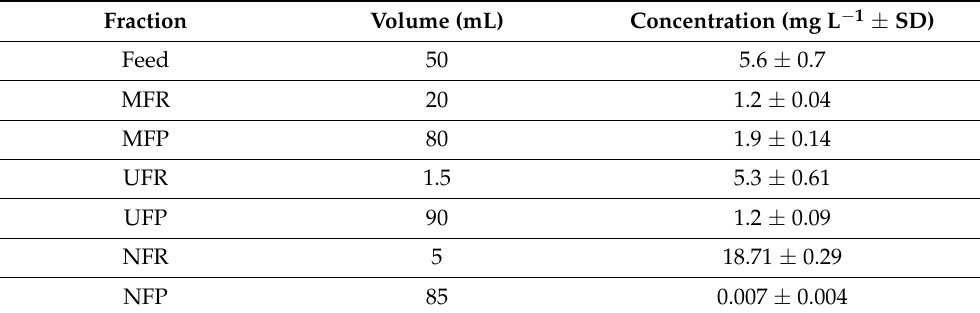
Figure 5. Total peak area of shinorine (SH) for each fraction calculated from HPLC data for the feed, and membrane filtration permeates and retentates. Peak area normalised for the volume of each fraction obtained during filtration. Error bars represent standard deviation. Table 2. Volume and MAAs concentration of all filtration fractions calculated from mAU.